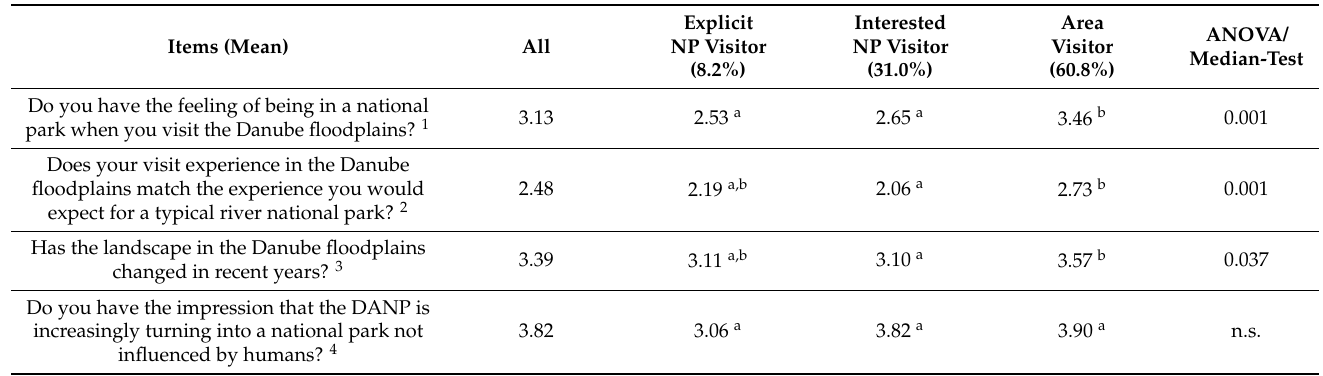
Table 3. National park affinity segments and national park perceptions (n =